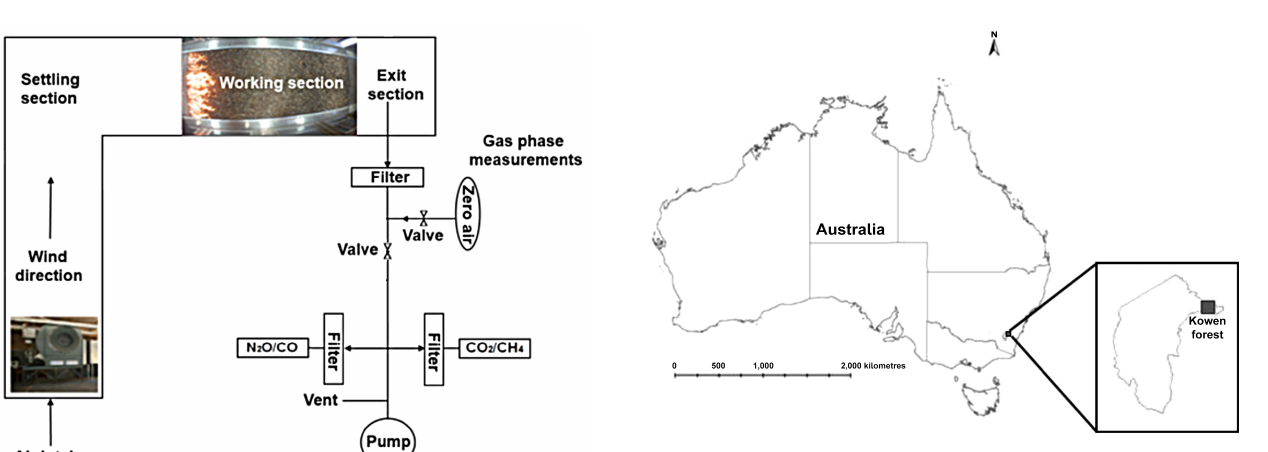
Figure 2. Location of the dry sclerophyll eucalypt forest for collec- tion of litter (35 ◦ 19 (cid:48) 30.07 (cid:48)(cid:48) S, 149 ◦ 15 (cid:48) 25.64 (cid:48)(cid:48) E). Shapefile of Aus- tralia sourced from the Department of Agriculture